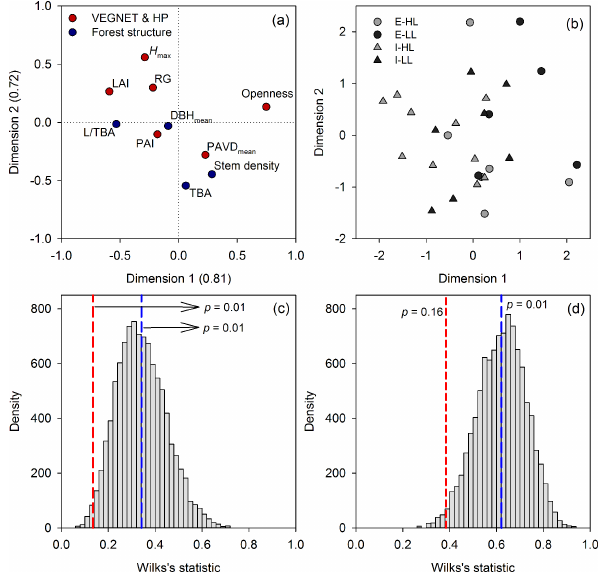
Figure 2. Canonical correlation analysis to describe the associa- tion between the parameters estimated by the VEGNET system– hemispherical photographs (HPs) and the forest structure. (a) VEGNET–HP coefficients are represented by red points, while for- est structure coefficients are represented by blue points. (b) Individ- ual scores for each plot of the canonical variates are represented ac- cording to successional stages (E, early; I, intermediate) and relative liana abundance (LL, low liana abundance; HL, high liana abun- dance). Panels (c) and (d) represent the permutation distribution of the Wilks’ Lambda test to assign the statistical significance of canonical correlation coefficients considering four and three canon- ical correlations; the red line represent the original value of Wilks’ Lambda, while the blue line represent the mean value permutated. The p values next to each line represent the significance of the Wilks’ Lambda test.